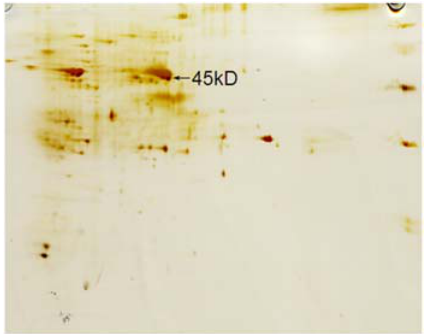
Figure 3. The ecombinant baculovirus Bmgp64HA was detect- ed by 2-D electrophoresis. 45 kD HA protein was expressed in